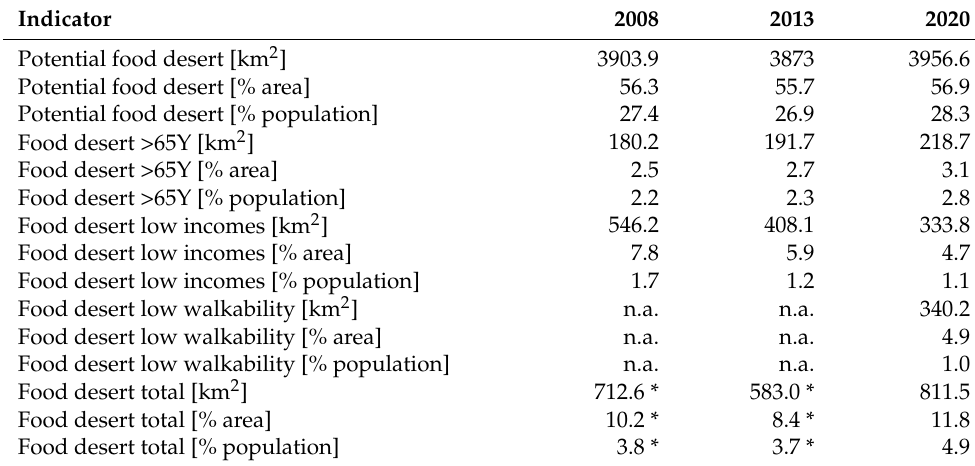
* Food desert total area and percentage of 2008 and 2013 are calculated without walkability data and cannot be compared with food desert total area of